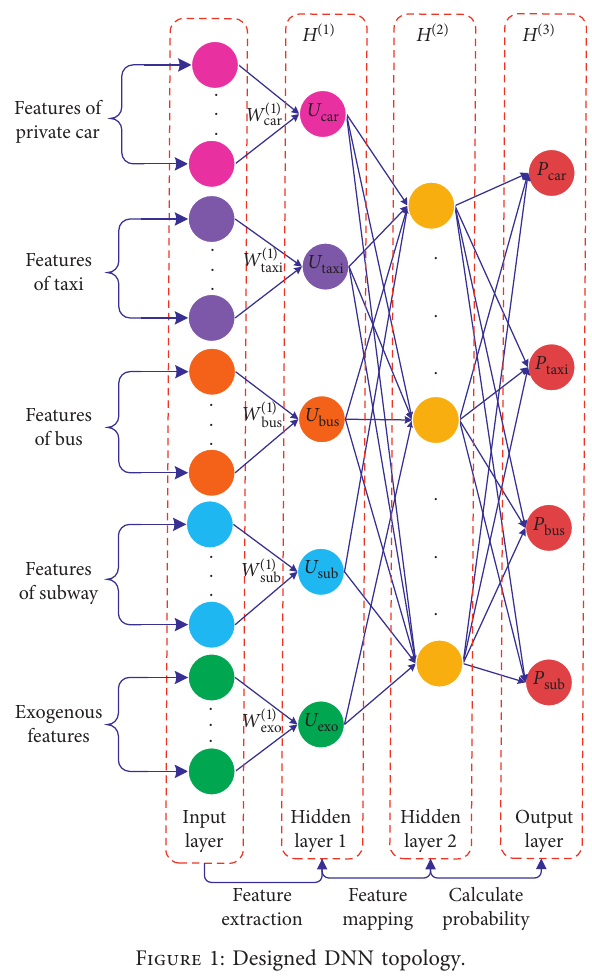
Figure 1: Designed DNN